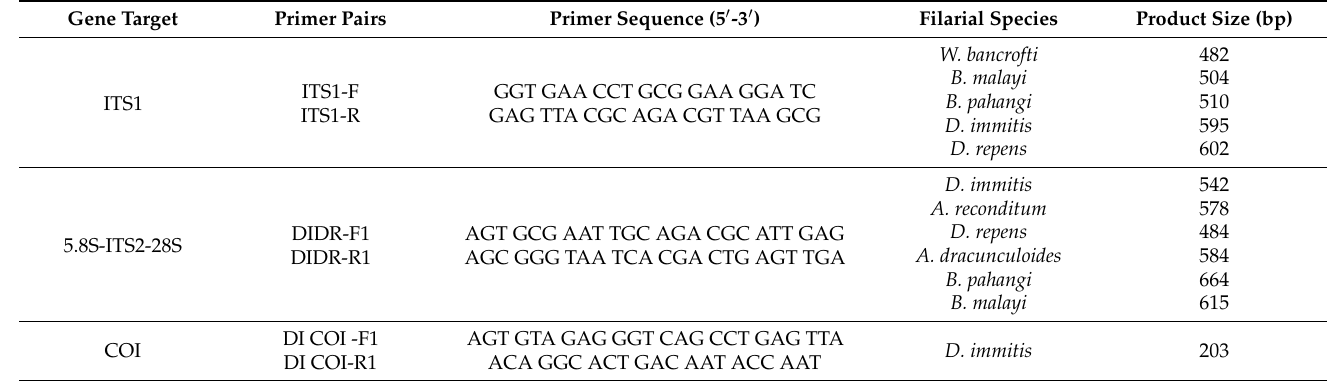
Table 1. Primer pairs used for PCR amplification.